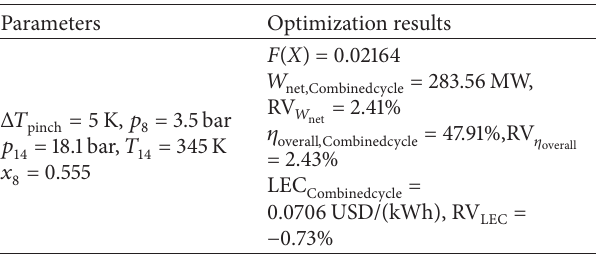
Figure 17: Variation of F ( X ) of combined cycle with ammonia mass fraction.